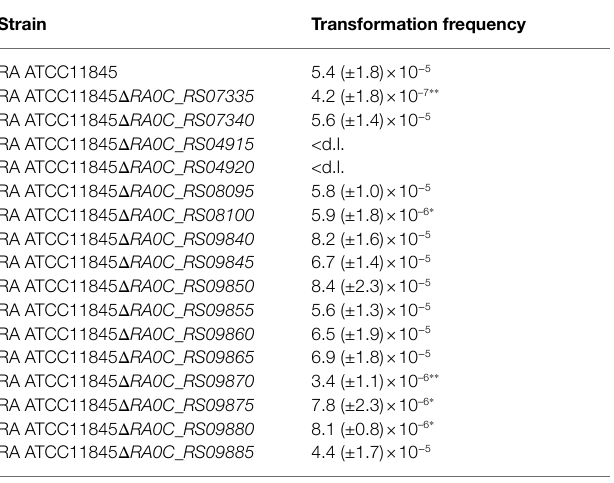
TABLE 2 | Natural transformation frequency of the wild type and indicated markerless mutants.